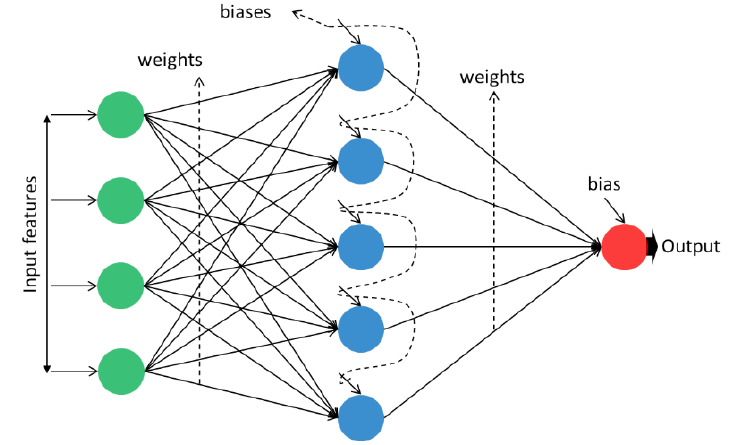
Figure 1. A single layer architecture of ANN.